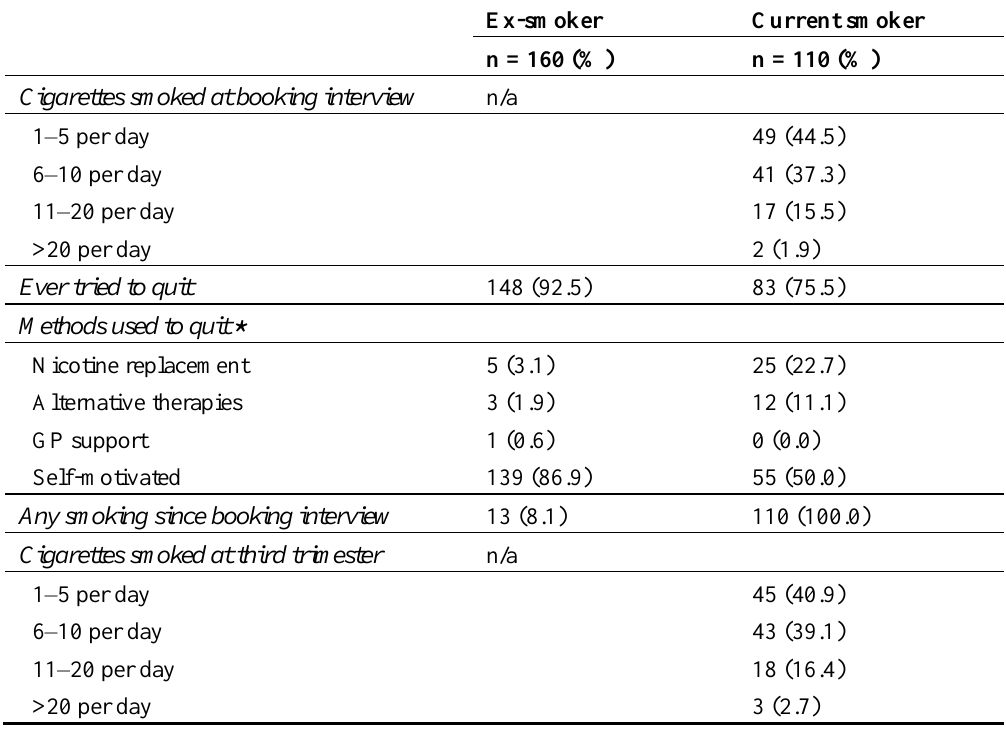
Table 2. Smoking behaviour in